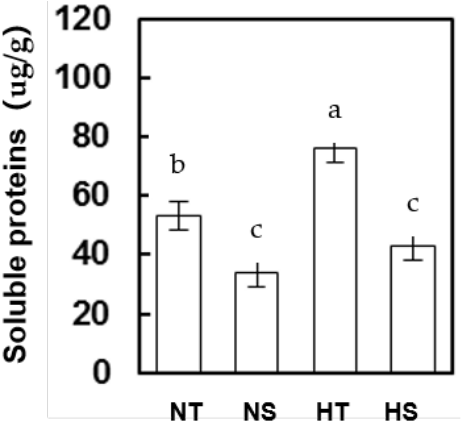
Figure 2. Accumulation of soluble proteins in tomato under high temperature stress with or without treatment of Spd. Note: Error bars represent SDs among three independent replicates. Values sharing the same letters are not significantly different ( p < 0.05; Duncan’s multiple range test). NT, normal growth condition under 25/18 ℃ and water; NS, normal growth condition under 25/18 °C with 1 mM Spd treatment on plants; HT, high temperature growth condition on 38/28 °C and water treat- ment; HS, high temperature growth condition on 38/28 °C with 1 mM Spd treatment on leaves.